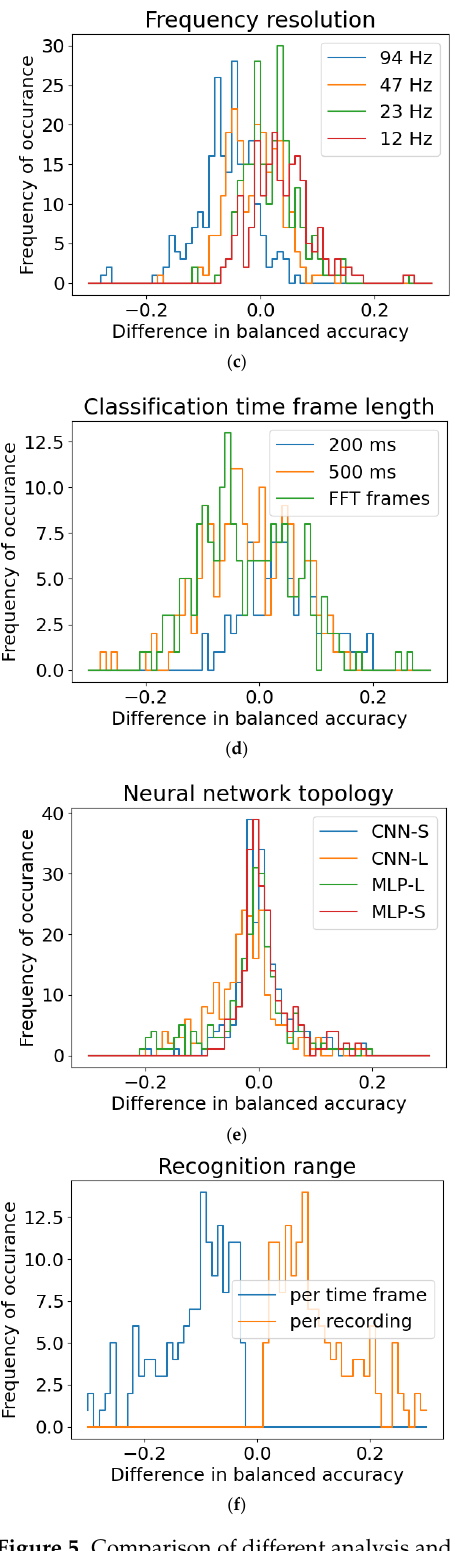
Figure 5. Comparison of different analysis and classification methods by the frequency of occur- rence of differences in balanced accuracy between classification exercises which differ in one parameter: ( a ) comparison of the six-class and four-class classification tasks, ( b ) comparison of the usage of one or both microphone signals, ( c ) comparison of different frequency resolutions, ( d ) comparison of different frames lengths, ( e ) comparison of different neural network topologies, and ( f ) comparison of processing the whole recording and the time frame.